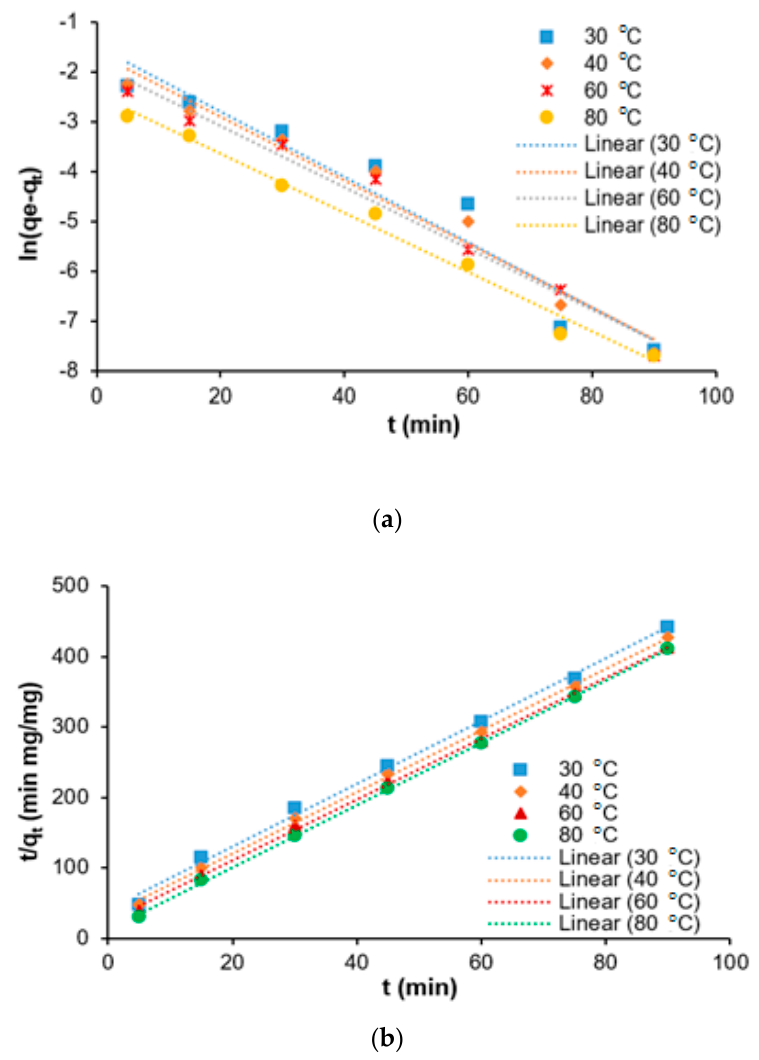
Figure 10. Adsorption kinetics studies for the removal of BOD from SRPE using FeSO 4 ·7H 2 O as a coagulant. ( a ) Pseudo-first-order kinetic model and ( b ) pseudo-second-order kinetic model.